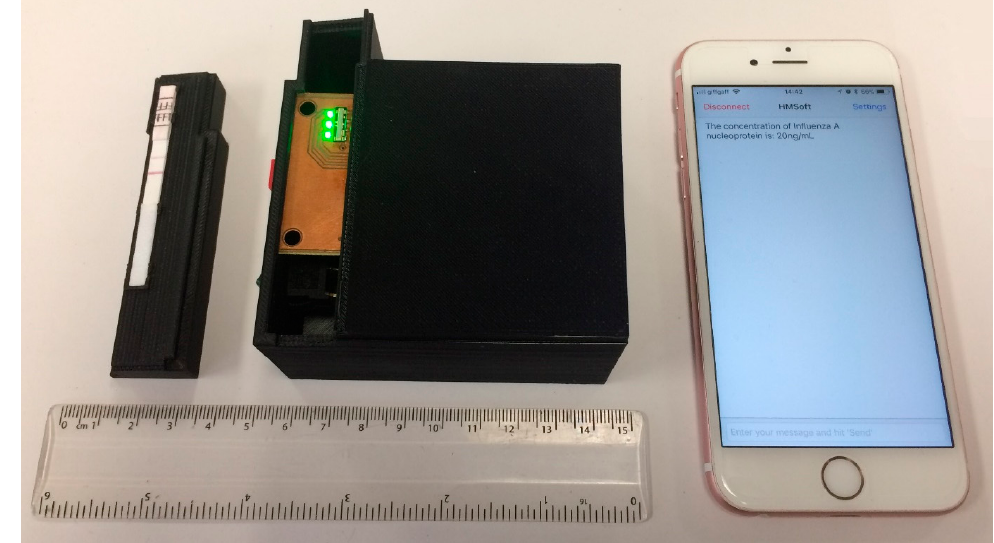
Figure 7. Photograph of the device. The lid is open, showing the carrier where the LFIA is placed fixed in the appropriate position.